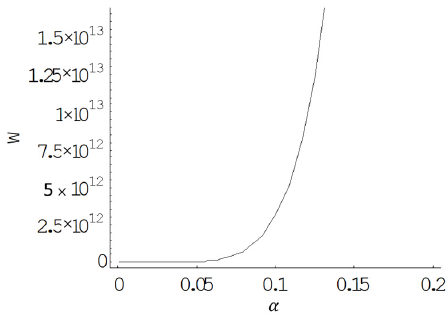
Figure 10. Total cost versus parameter α .